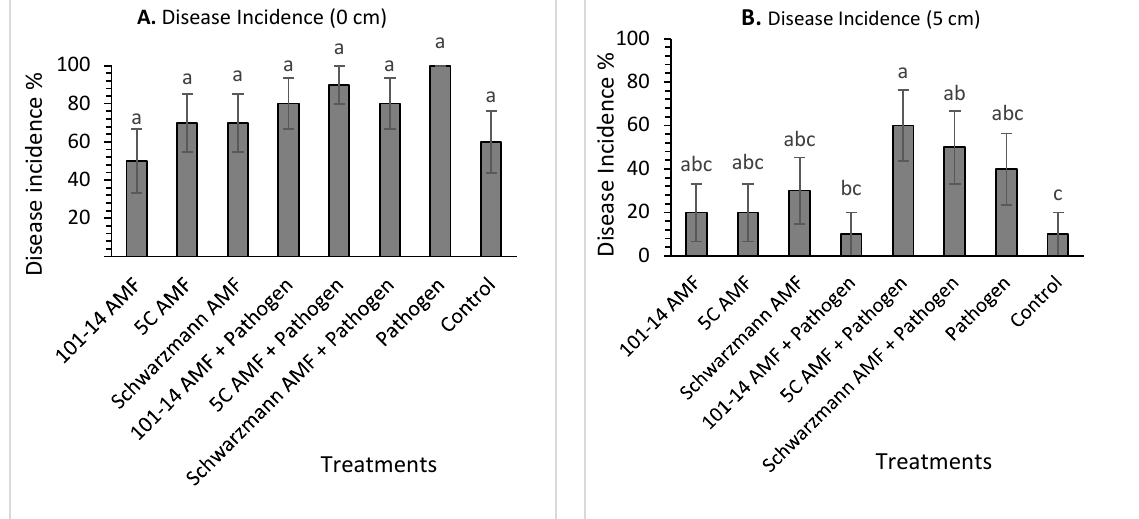
Figure 4. Mean black foot disease incidence (%) for rootstock 101-14 at 0 cm ( A ) and 5 cm ( B ) from the stem base colonized with different AMF communities originating from different rootstocks (101-14, 5C and Schwarzmann) and inoculated with black foot pathogen isolates. Bars with different letters are significantly different ( p ≤ 0.05) based on the SED generated from GLM analysis. Error bars show ± SED.